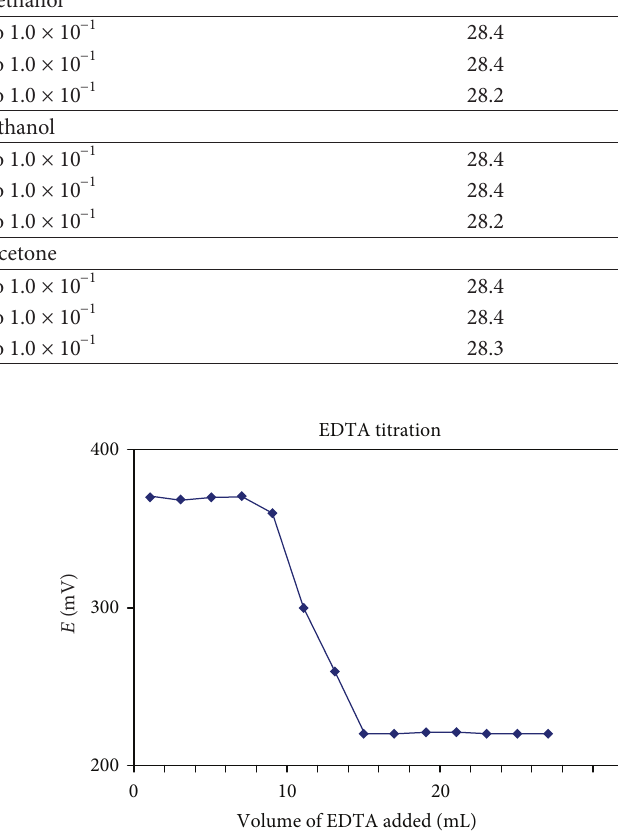
T 2: Effect of partially nonaqueous medium on the working of Mg 2+ selective sensors (sensor no. 4). Non-aqueous content